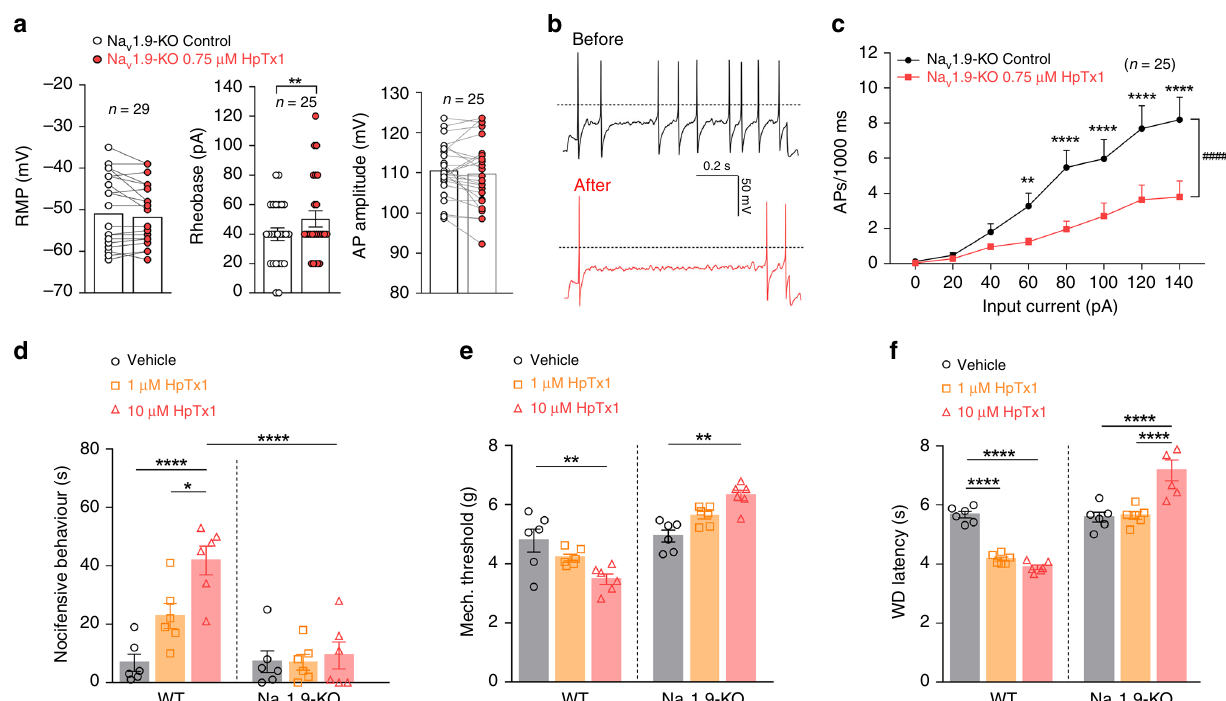
Fig. 4 HpTx1-evoked pain hypersensitivity relies on Na v 1.9 activity. a – c Current-clamp recordings show that HpTx1 decreases the membrane excitability of small DRG neurons from Na v 1.9-KO mice. a Bars show no signi fi cant changes in RMP (left, n = 29) or AP amplitude (right, n = 25), but a signi fi cant increase in rheobase (middle, n = 25, nonparametric Wilcoxon matched-pair signed-rank two-tailed test: P = 0.008) in the presence of 0.75 μ M HpTx1. b AP traces recorded from a representative small Na v 1.9-KO DRG neuron before (black) and after (red) application of 0.75 μ M HpTx1. The dashed lines indicate 0 mV. c Statistics plots show signi fi cant decreases in AP spike number in the presence of 0.75 μ M HpTx1 ( n = 25, two-way repeated measures ANOVA followed by Bonferroni ’ s multiple comparisons test, treatment × inject current: F (7,168) = 8.834, P < 0.0001; treatment: F (1,24) = 25.49, #### P < 0.0001; inject current: F (7,168) = 25.28, P < 0.0001). d Comparison of nocifensive behaviors (licking or biting) following intraplantar injection of vehicle (10 μ l 0.9% saline, n = 6) versus HpTx1 (1 μ M or 10 μ M in 10 μ l saline, n = 6) (two-way ANOVA followed by Tukey ’ s multiple comparisons